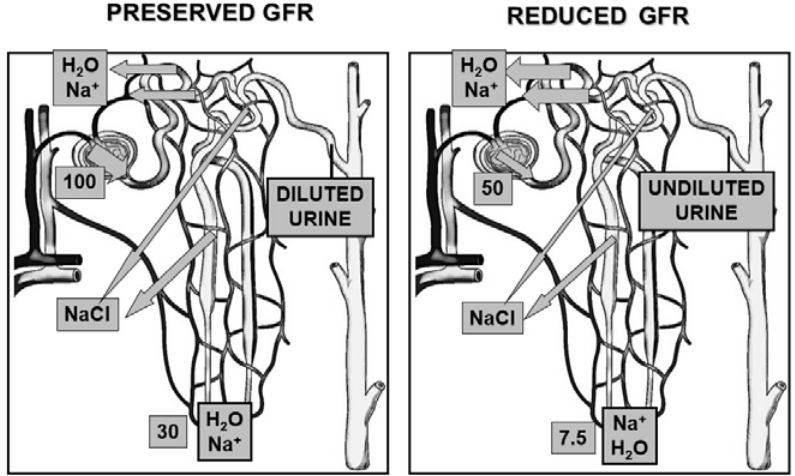
Figure 2. Schematic representation of sodium and water handling in case of preserved and reduced glomerular filtration rate (GFR). Preserved GFR: reabsorption of sodium